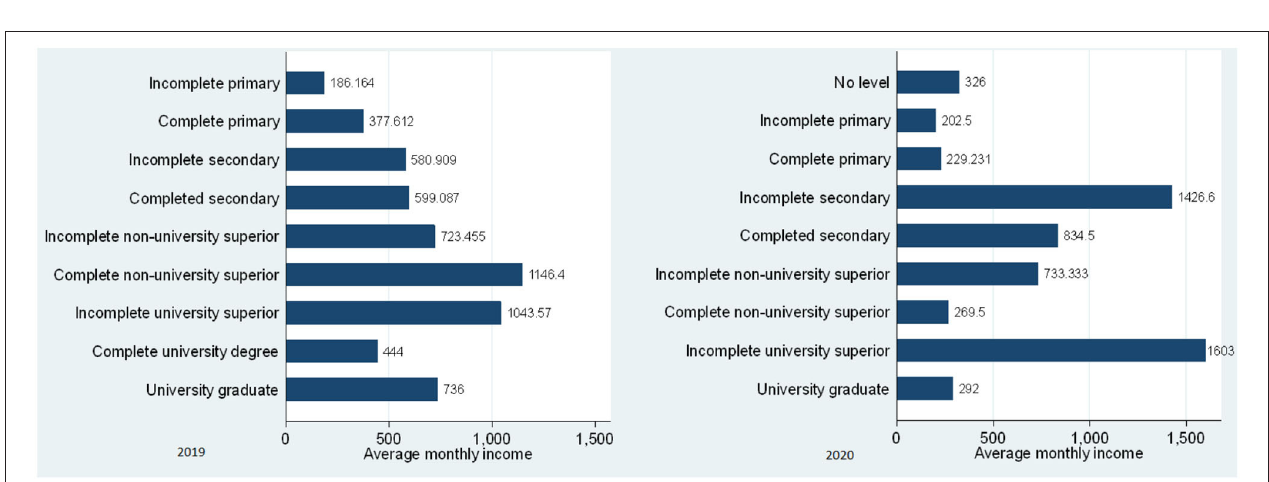
FIGURE 3 | Average monthly economic income of self-employed workers by educational level, 2019–2020. Source: Own elaboration with information from ENAHO-INEI-2019 and 2020.